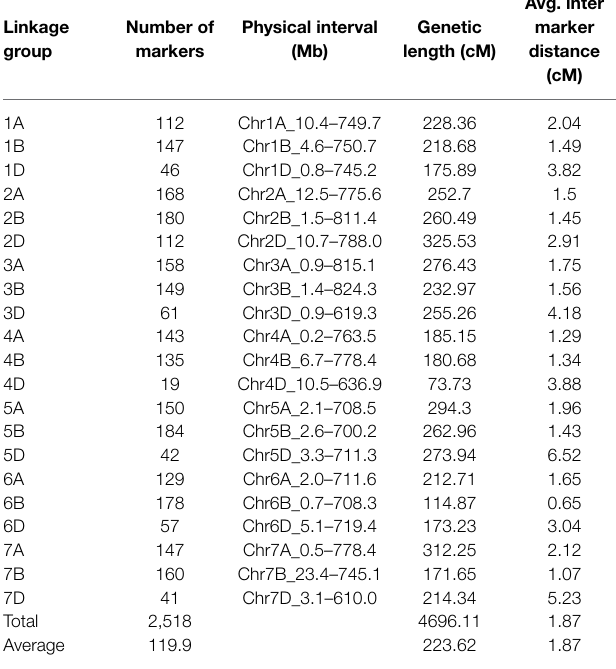
TABLE 1 | Linkage analysis of molecular markers in Baiqimai/Neixiang 5 DH population.